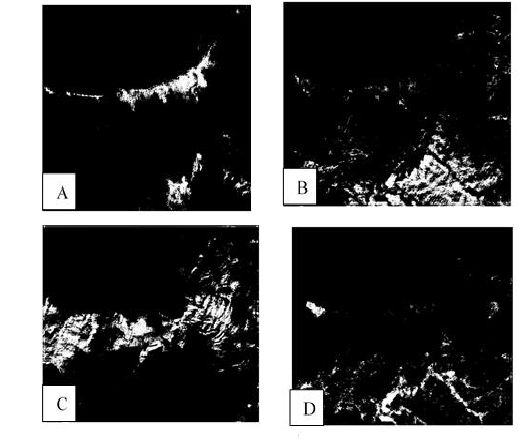
Figure 4 : Probability heatmap of Land cover classes resulted from CNN model with values between 0 and 1 (black to white);